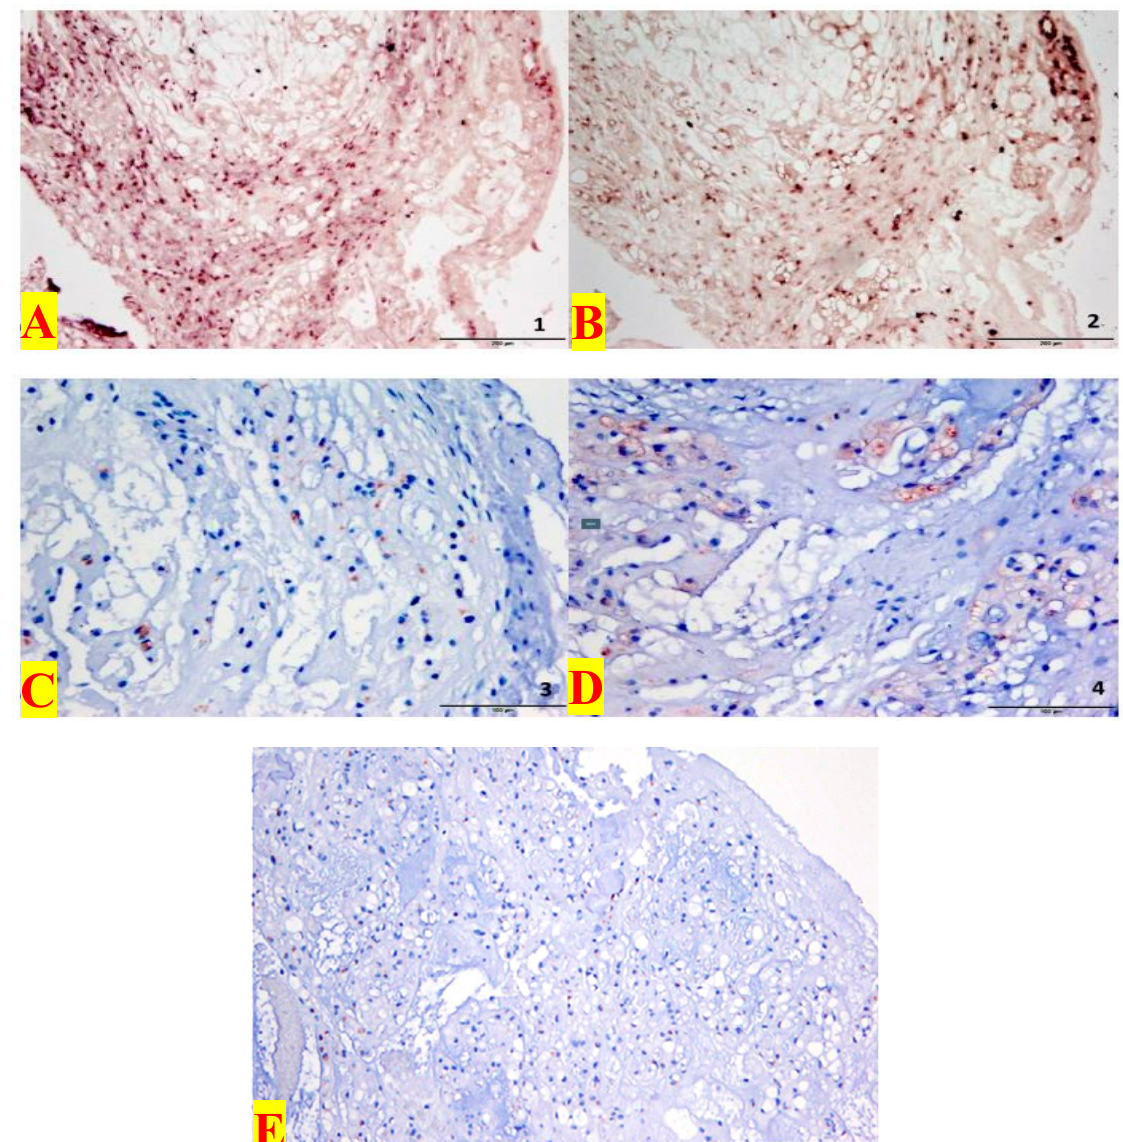
Figure 3. Comparison of a cranial chordoma sample from a patient after positive in situ hybridization (Ptch1 (+), Gli1 (+)) and immunohistochemical staining (Shh (+) and Gli1 (+)) in comparison: ( A ): In situ hybridization Ptch1 (+) at 100 × magnification. ( B ): In situ hybridization Gli1 (+) at 100 × magnification. ( C ): Immunohistochemistry Shh (+), score 2, magnified 200 times. ( D ): Immunohistochemistry Gli1 (+), Score 2, in 200 × magnification. ( E ): For negative control, the primary antibody was substituted by PBS (Phosphate-buffered saline). All slides were run simultaneously under identical conditions and negative control slides were included. Slides in which incubation with primary antibody was omitted served as the negative controls for each antigen retrieval regimen .